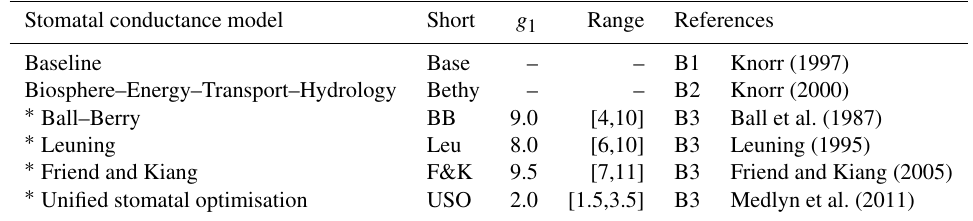
Table 3. Stomatal conductance models with default values and range for g 1 and references to equations in Appendix B as well as related